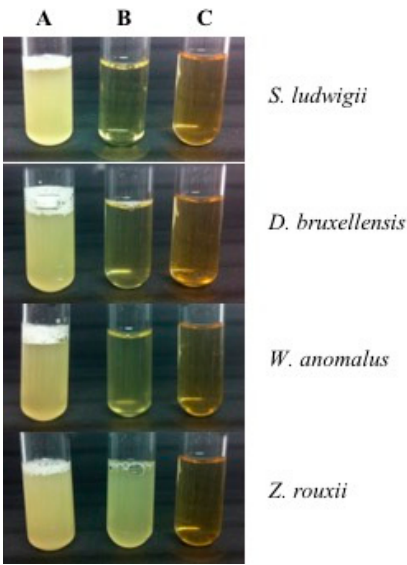
Figure 3. Use of β -glucanases as yeasts inhibitors. The tubes contain the yeasts species S. ludwigii , D. bruxellensis , W. anomalus and Z. rouxii in yeast extract peptone dextrose (YEPD) liquid growing media with same optical density. ( A ) control, ( B ) β -glucanase 1 and ( C ) β -glucanase 2.